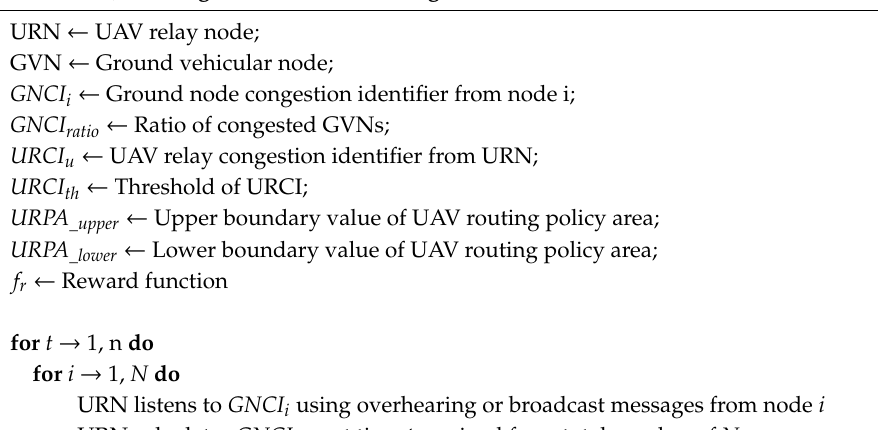
Algorithm 1: Q-learning based Load